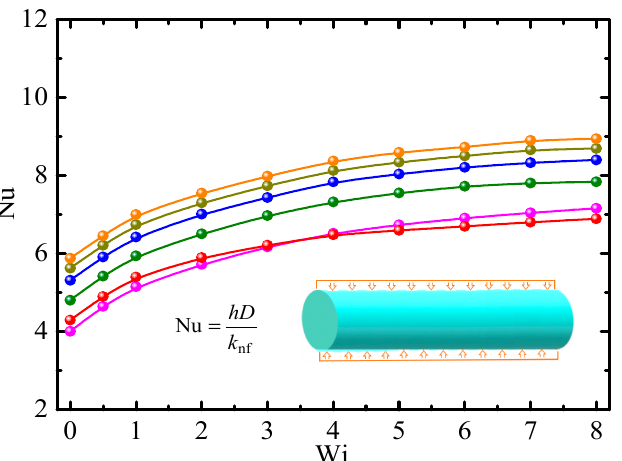
Figure 8. Nusselt number vs. Weissenberg number for different particle concentrations ( β 0 = 0.2, Re = 2.5, α = 0.2). — • —: Φ = 0% (Giesekus fluid) [32]; — • —: Φ = 0% (Giesekus fluid); — • —: Φ = 0.5%; — • —: Φ = 1.0%; — • —: Φ = 2.0%; and — • —: Φ = 3.0%.